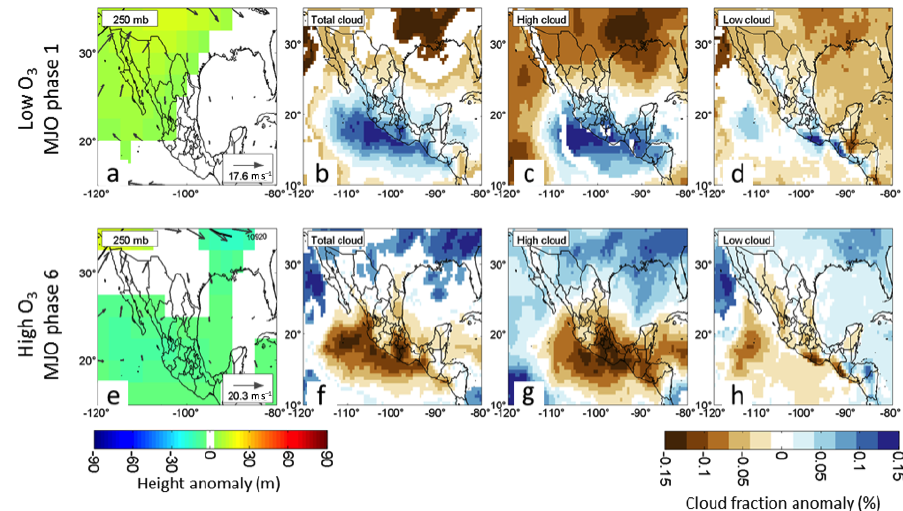
Figure 9. As in Fig. 8, but for summer days in active MJO phase 1 (a–d) and active MJO phase 6 (e–h) . Phases 1 and 6 were the phases with lowest and highest respective summer ozone concentrations in Mexico